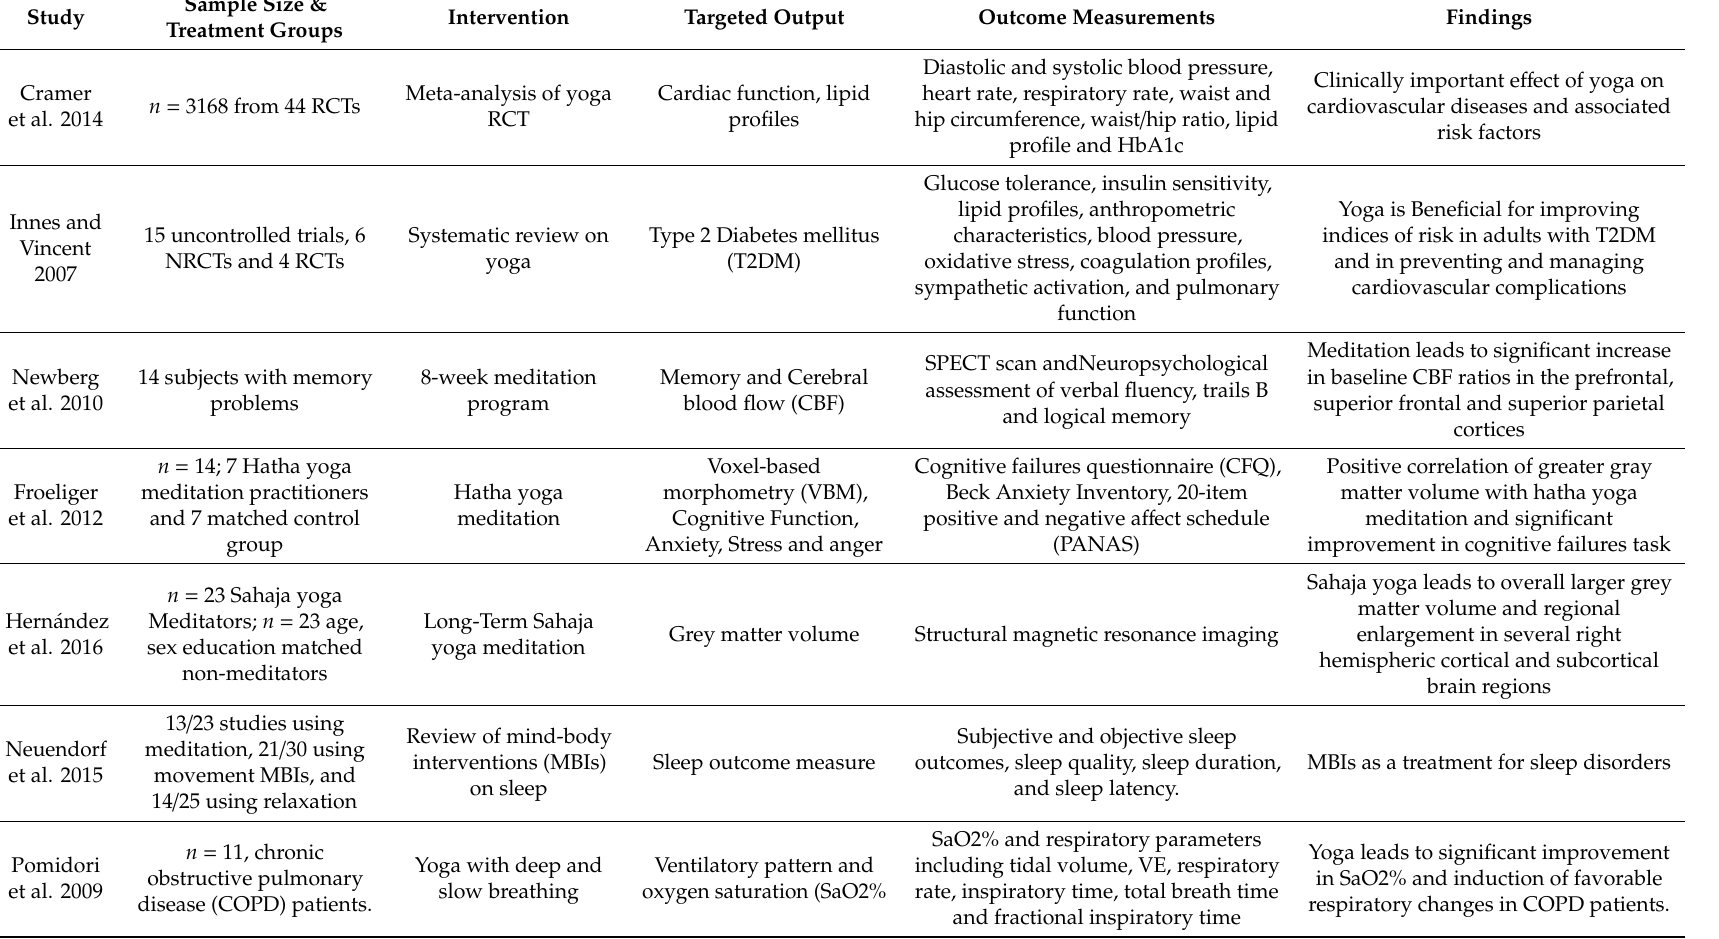
Table 1. Summary of studies examining e ff ect of MBTs on